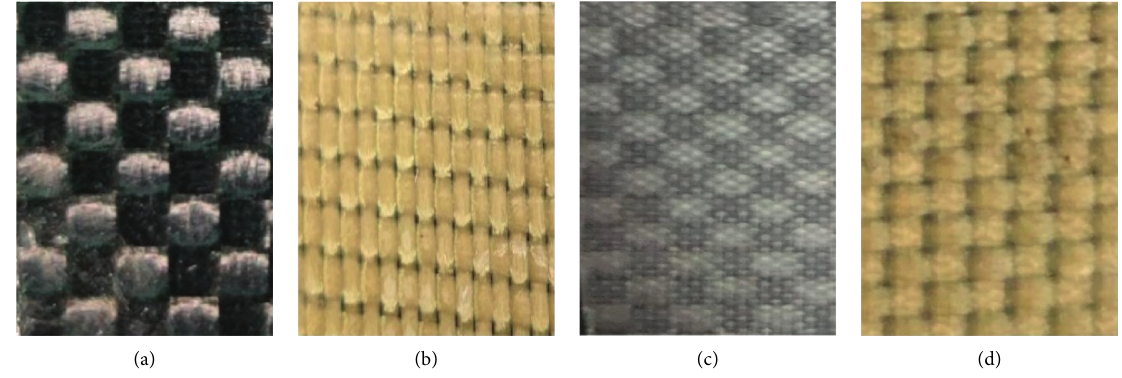
Figure 2: Pictures of composites. (a) Aramid/BS-4. (b) Aramid/4211. (c) T300/BS-4. (d)